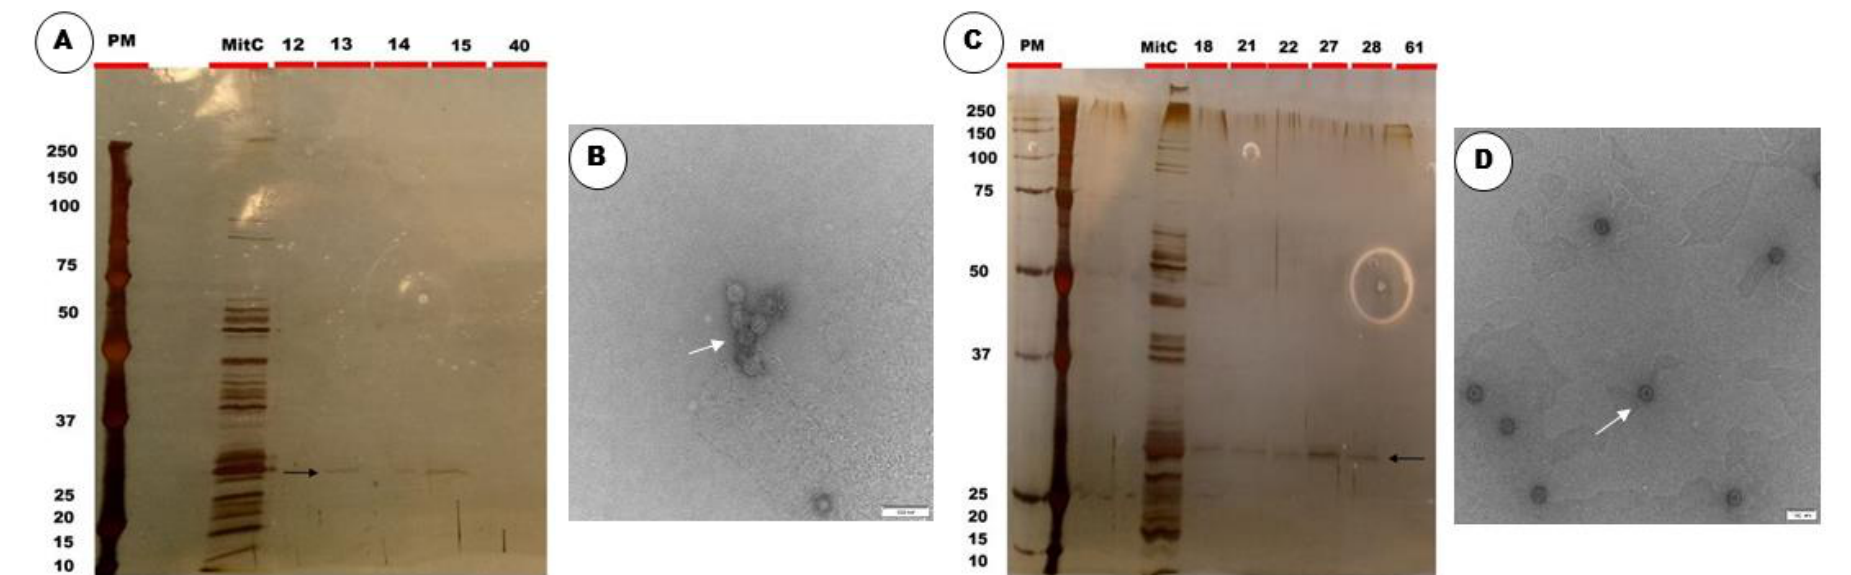
Figure 4. SDS-PAGE and TEM analysis of Bl 1951 putative antibacterial protein purified using SEC. SDS-PAGEs of SEC fractions 12, 13, 14, 15, 40 ( A ) and SEC fractions 18, 21, 22, 27, 28, 61 ( C ) showing a purified protein of ~30 kD (shown with a dark arrow; see SEC chromatogram, Figure S2). Electron micrographs of Bl 1951 SEC-purified putative antibacterial protein fraction no. 15 ( B ) and fraction no. 27 ( D ) showing uniformly sized hexagonal or phage capsid-like structures (with white arrows). Scale bar = 100 nm. PM and MitC denote protein marker and mitomycin C, respectively. MitC-induced culture cell-free supernatant was loaded into the MitC lane.